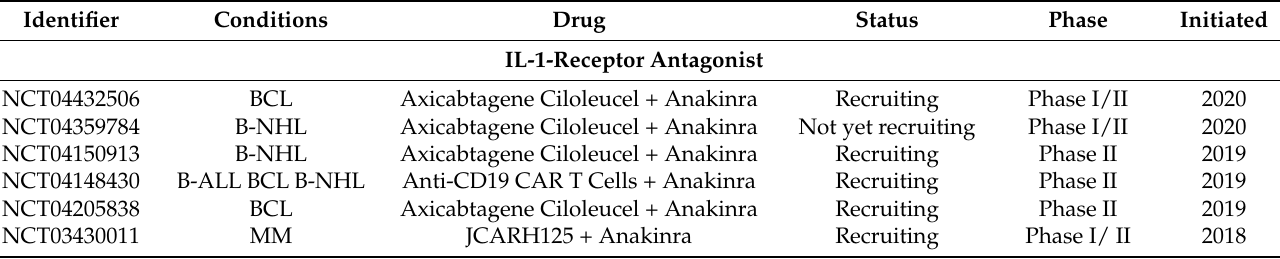
Table 2. Overview of clinical trials combining IL-1-blockade and CAR T cell